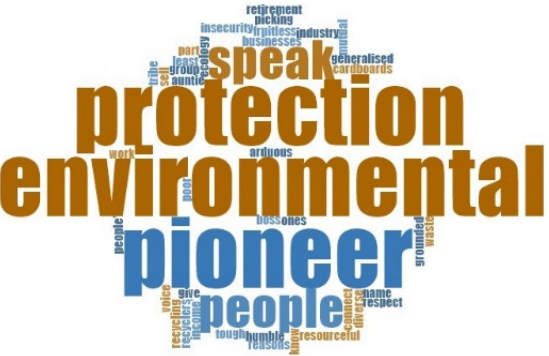
Figure 1. Key Informants’ descriptions of the Older Adult IWPs.